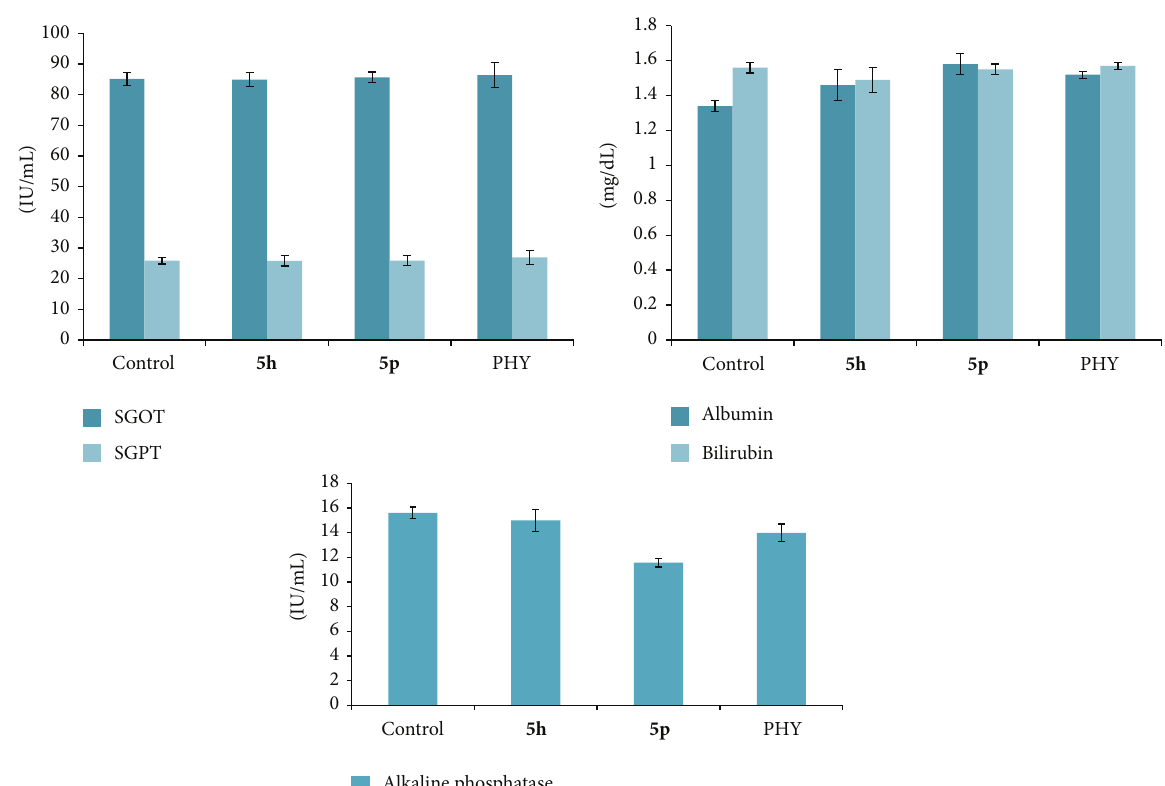
Figure 1: Hepatic enzymes estimations after treatment with different test compounds. Number of animals tested ( 𝑛 = 6 ). The mean levels were calculated using ANOVA followed by Dunnett’s test.